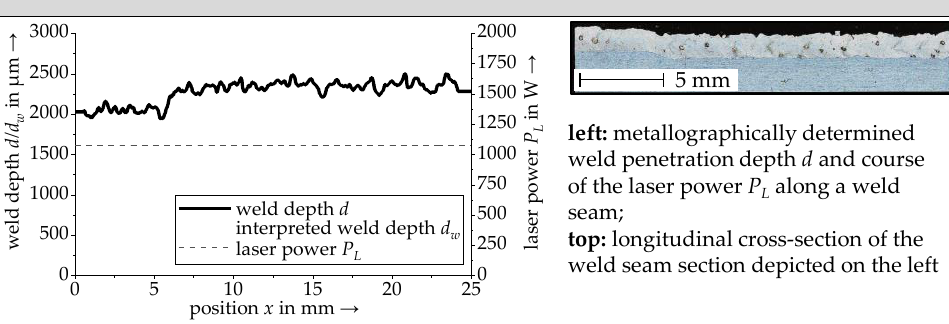
Figure 8. Comparison of the weld depth profiles for a targeted depth of 1.5 mm with a 300 µ m deep notch for the aluminum alloy AA2219 with active weld depth control (top), for the aluminum alloy EN AW-6082 with active weld depth control and for the aluminum alloy EN AW-6082 without weld depth